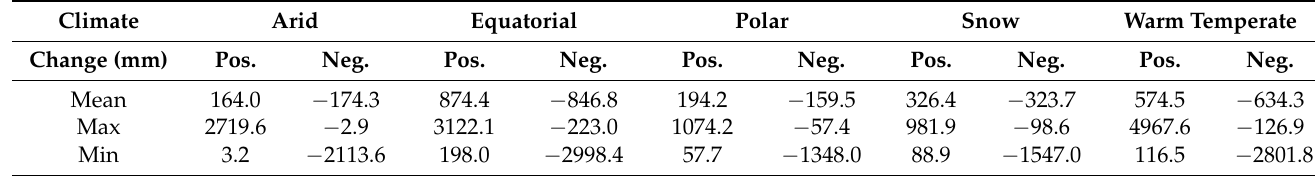
Table 4. Statistical description of precipitation changes in different climate